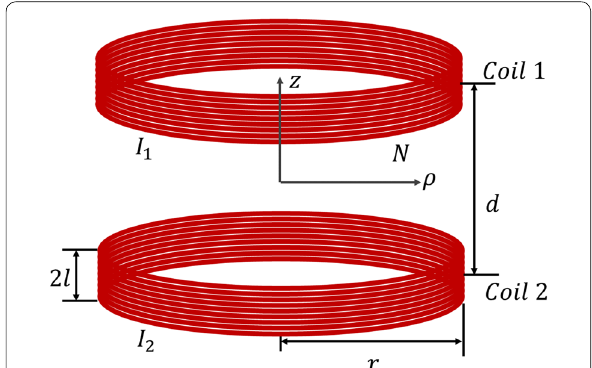
Figure 4 Pair of loop-coils consisting of two single coils with currents of the same magnitude flowing in the coil